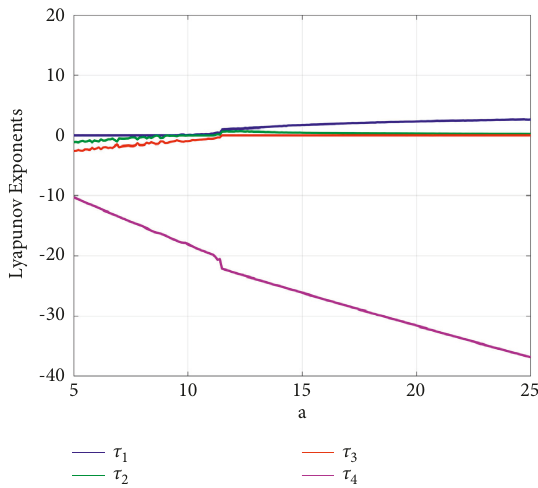
Figure 3: Lyapunov exponents for the model (1) when a varies in [ 5 , 25 ] and ( b, c, d ) � ( 8 , 90 , 6 ) .